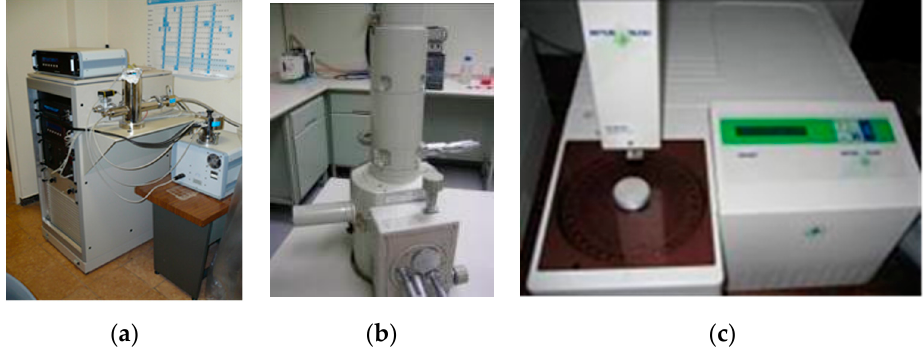
Figure 2. ( a ) Dynamic electric analysis (DEA) test system, ( b ) JEOL 5610 SEM microscope, and ( c ) Mettler Figure2. ( a )Dynamicelectricanalysis(DEA)testsystem, ( b )JEOL5610SEMmicroscope, and ( c ) Mettler DSC-822e equipment for thermal analysis. DSC-822e equipment for thermal